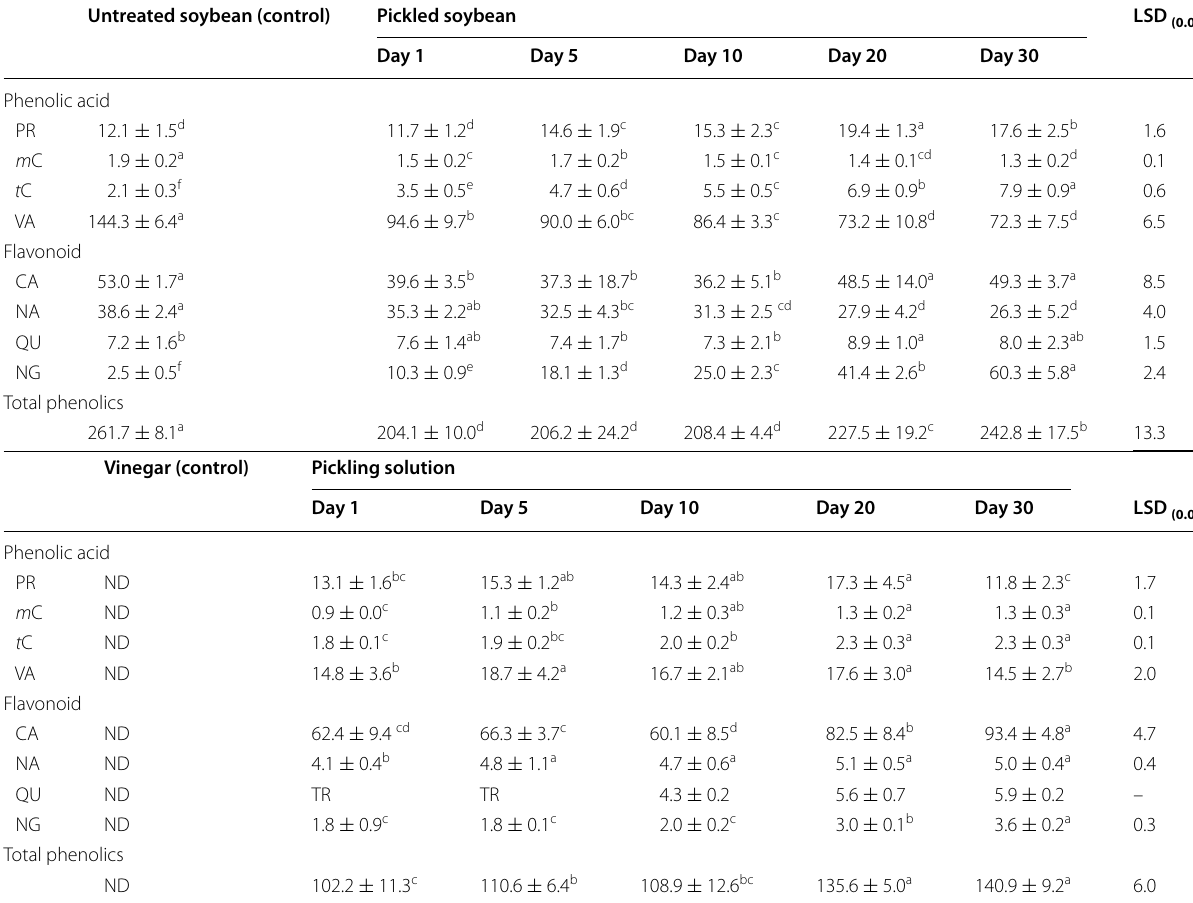
Table 1 Change in phenolic compounds content in soybeans during the 30-day pickling process (μg g − 1 , dry basis, P < 0.05, n =